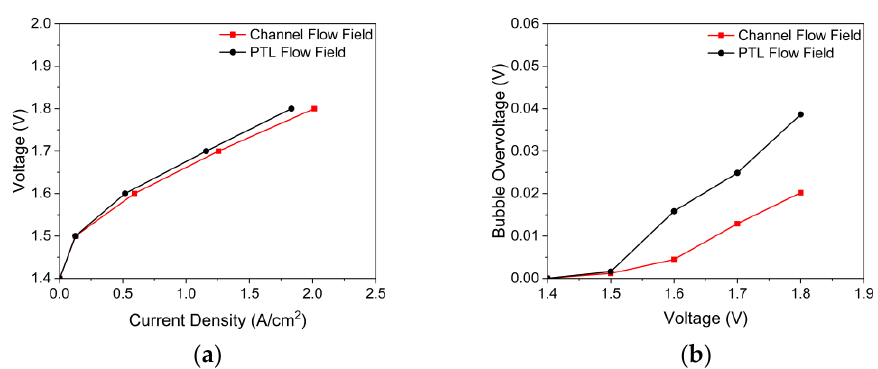
Figure 7. ( a ) Polarization curves and ( b ) bubble overvoltage curves of PEMWE according to the anode flow field curves ( ε : 0.75, K : 30.2 × 10 −12 m 2 , θ : 30°, 𝑄̇ 𝑖𝑛 : 10 sccm, T in : 328.15 K, T cell : 328.15 K, and 𝑔⃗ : z+).